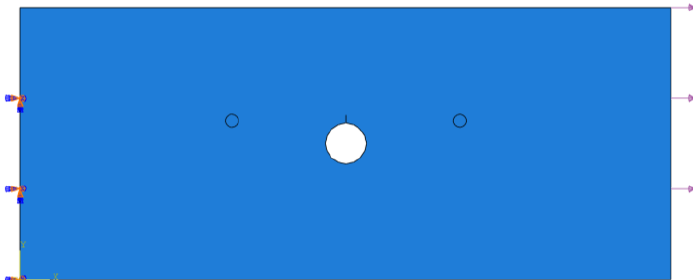
Figure 4. FE model of center-hole metal specimen using ABAQUS/Explicit.